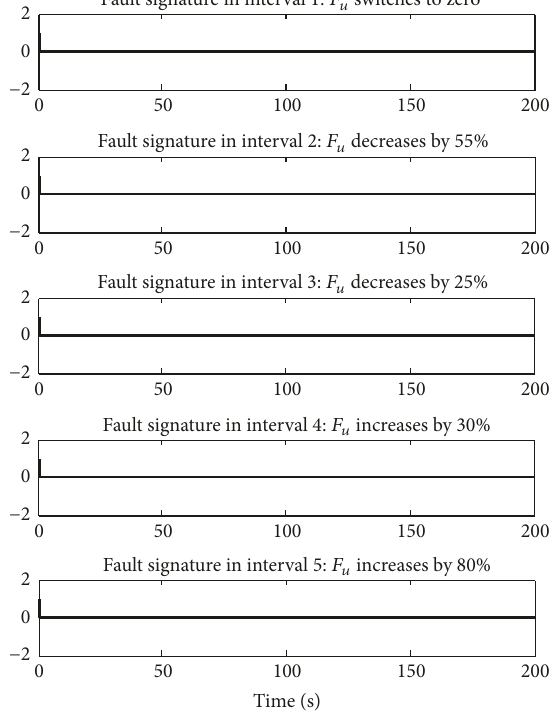
Figure 16: Fault signature sent by parameter filters of utility fluid 𝐹 𝑢 .